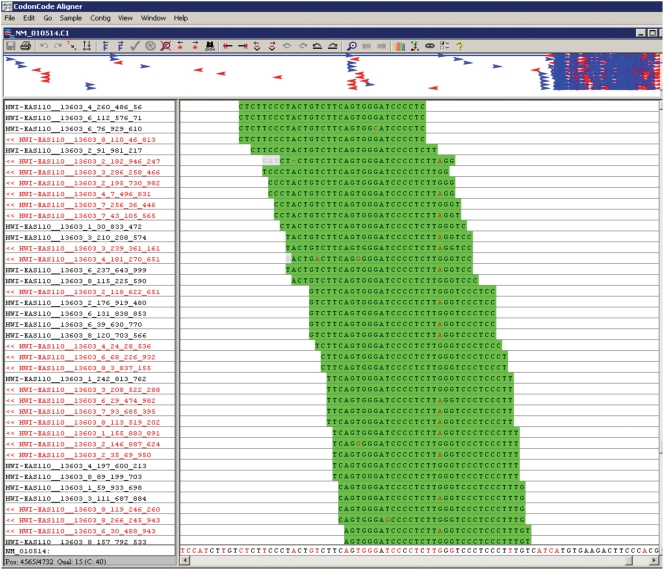
Alignment of Illumina sequence reads for Igf2 transcript.The top panel is the summary window or all 1,253 cDNA reads that mapped to the 4,038 bp Igf2 transcript (NM_010514). The blue arrows represent the sense reads and the red arrows represent antisense reads. From the figure, most of the reads were aligned to the 1 kb region near the 3′-end of the transcript. The bottom left panel gives the Illumina read names, and the bottom right gives the sequence alignment. Sense reads are printed in black font and the antisense reads are in red font. There are many overlapping 32-bp reads aligned uniquely to the transcript, with a quality score for each nucleotide. There is a SNP (A/G) located in the middle. By directly counting the number of reference and alternative nucleotides at the SNP, we were able to quantify the relative expression level of the two parental alleles.